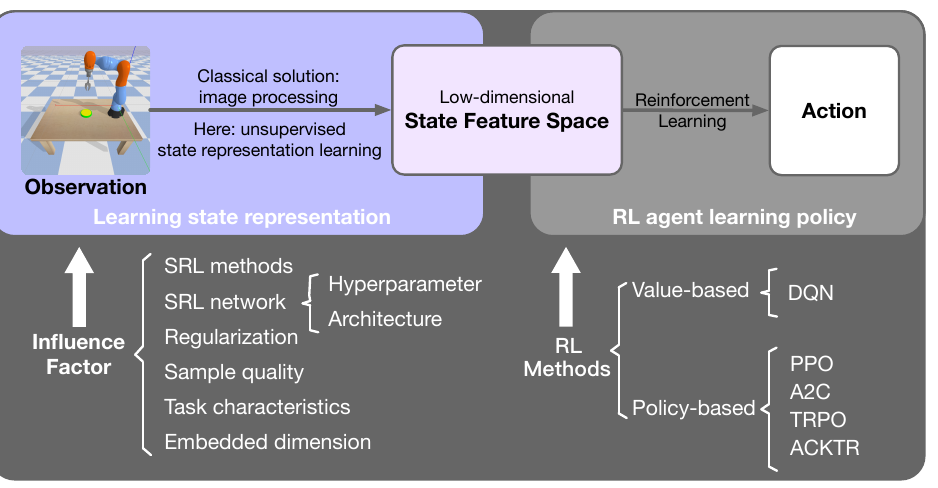
Figure 1. The unsupervised state representation learning (SRL) process and the corresponding influence factors from high-dimensional pixels for